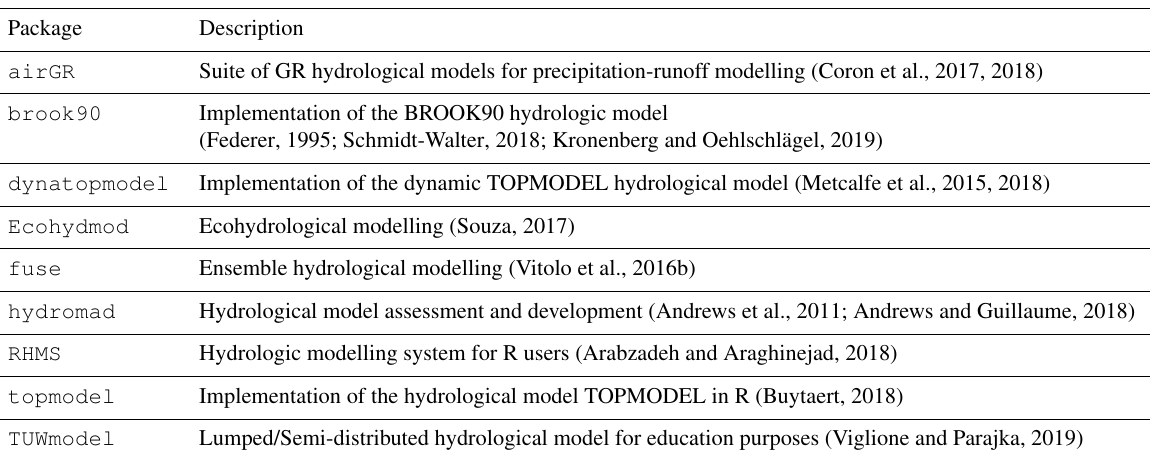
Table 2. Examples of packages for hydrological modelling. See the Hydrology Task View for latest additions: https://cran.r-project.org/web/